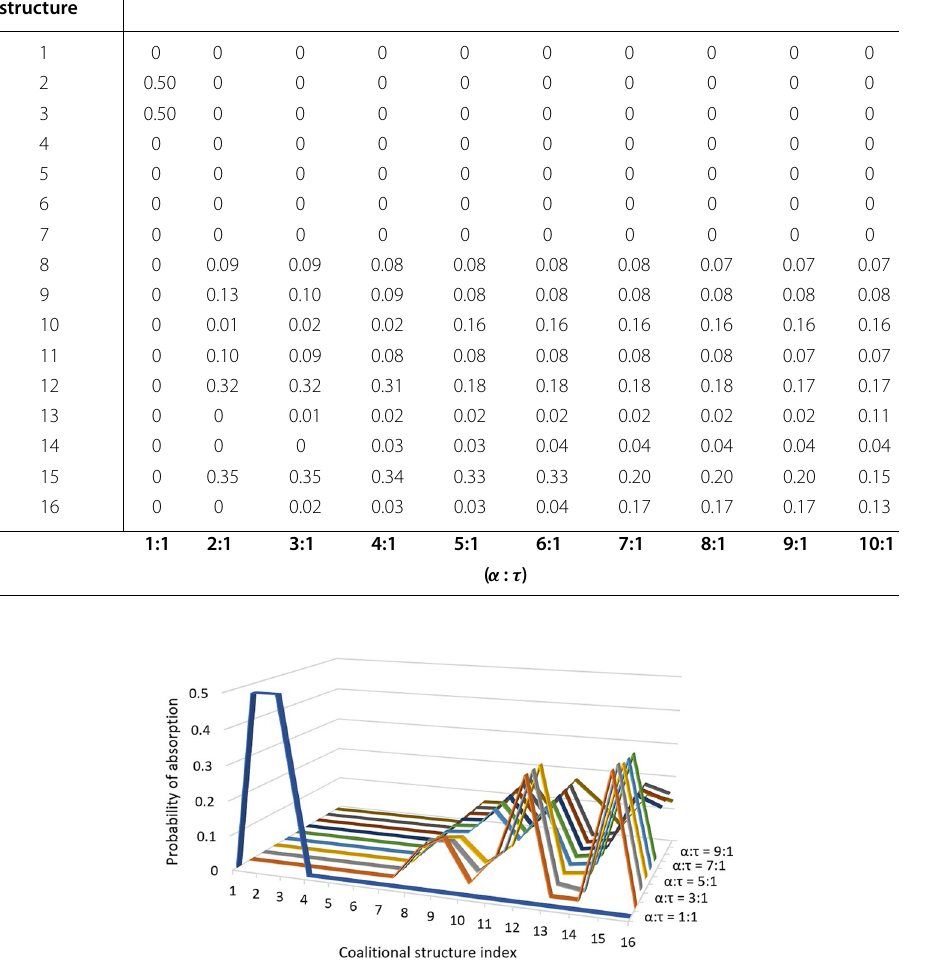
Table 1 Probability of absorption of each coalitional structure for weight coefficient α = 1,2, ... ,10 and τ 1 = Coalitional structure